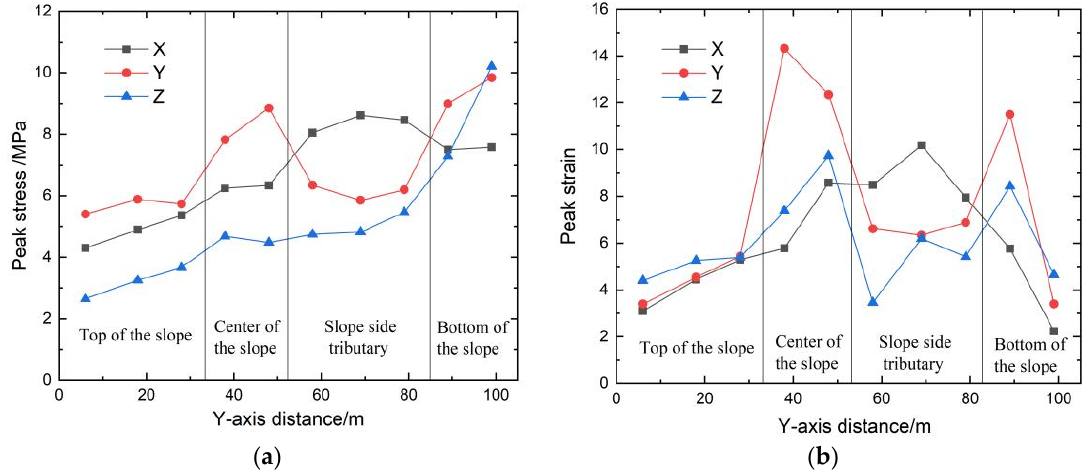
Figure 20. Peak stress and strain. ( a ) peak stress, ( b ) peak strain.